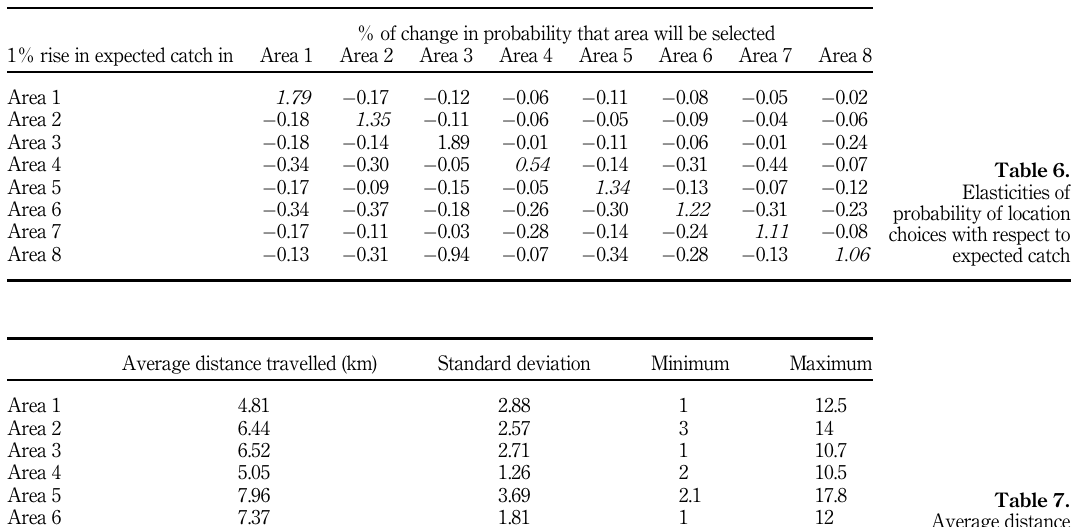
Table 7. Average